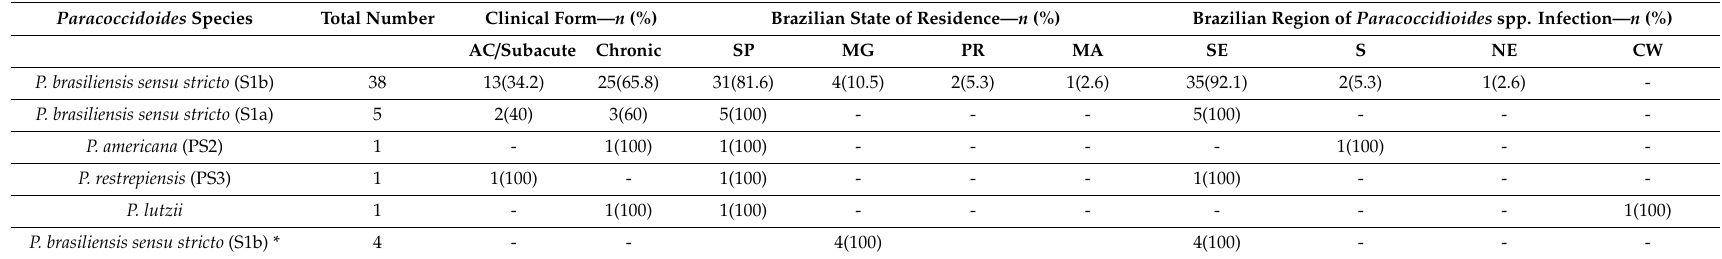
Table 1. Paracoccidoidomycosis clinical form, patient residence and Brazilian region where the infection probably occurred (or collection area in the case of environmental isolates), according to Paracoccidioides